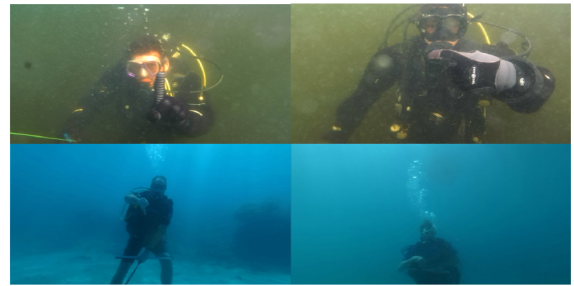
Figure 8. Example images of the SCUBANet [48]